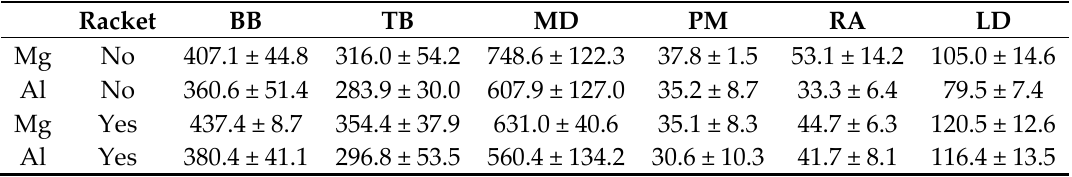
Table 3. Mean amplitude and standard deviation of mean amplitude for 20 s Dash (back stroke).